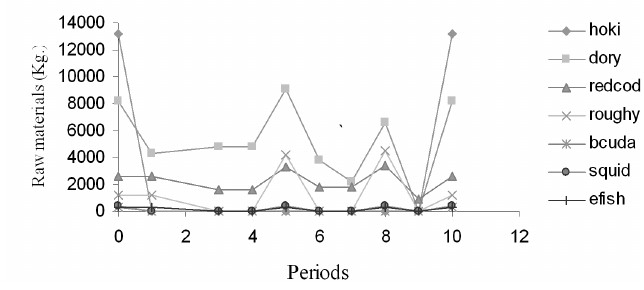
Figure 4: Inventory raw materials of each species in different